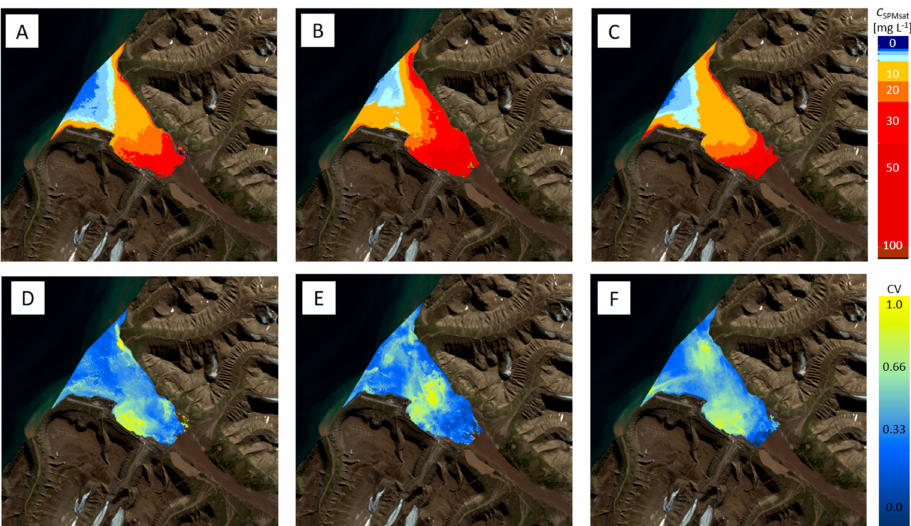
Figure 5. Composite images of mean values for C SPM (upper panels) and coefficient of variation sat (CV, lower panel) per pixel during the months of June ( A , D ), July ( B , E ), and August ( C , F ). Composite are based on both 2019 and 2020 satellite imagery (background corresponding to Sentinel-2 image in overview map of this study). Contains modified Copernicus Sentinel-2 data (2020, Sentinel-2 B image 27 July 2020) processed by Sentinel-Hub (https://scihub.copernicus.eu/, accessed on 28 June